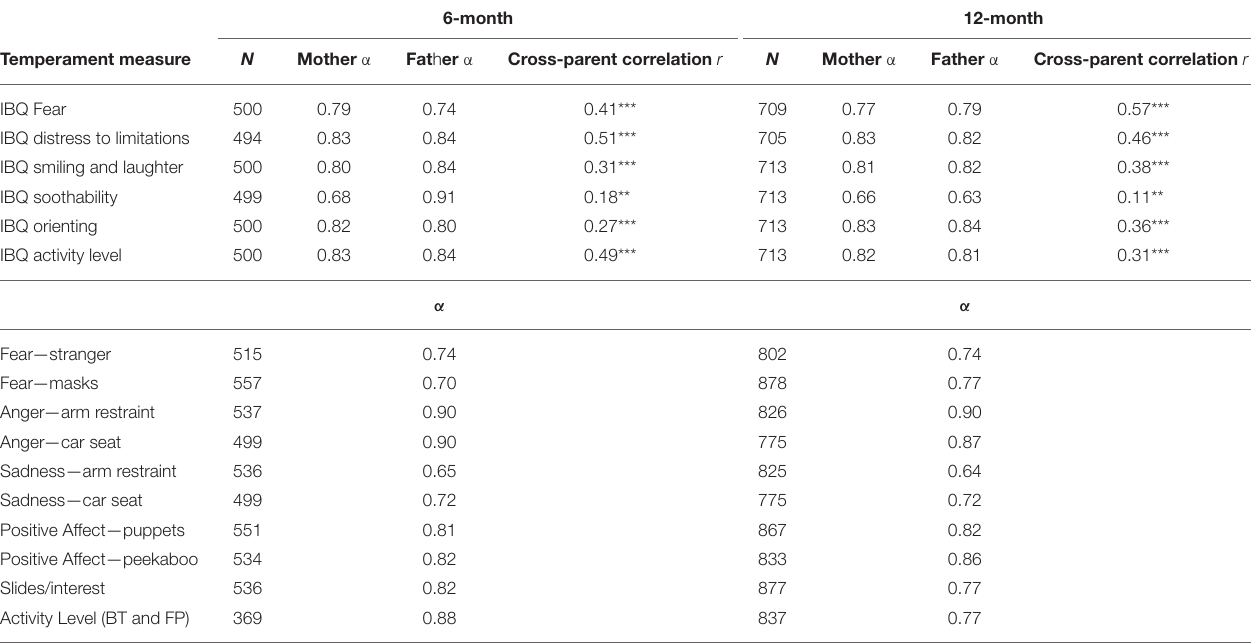
TABLE 2 | Internal consistency and cross-parent (mother-father) for IBQ scales and Lab-TAB infant temperament